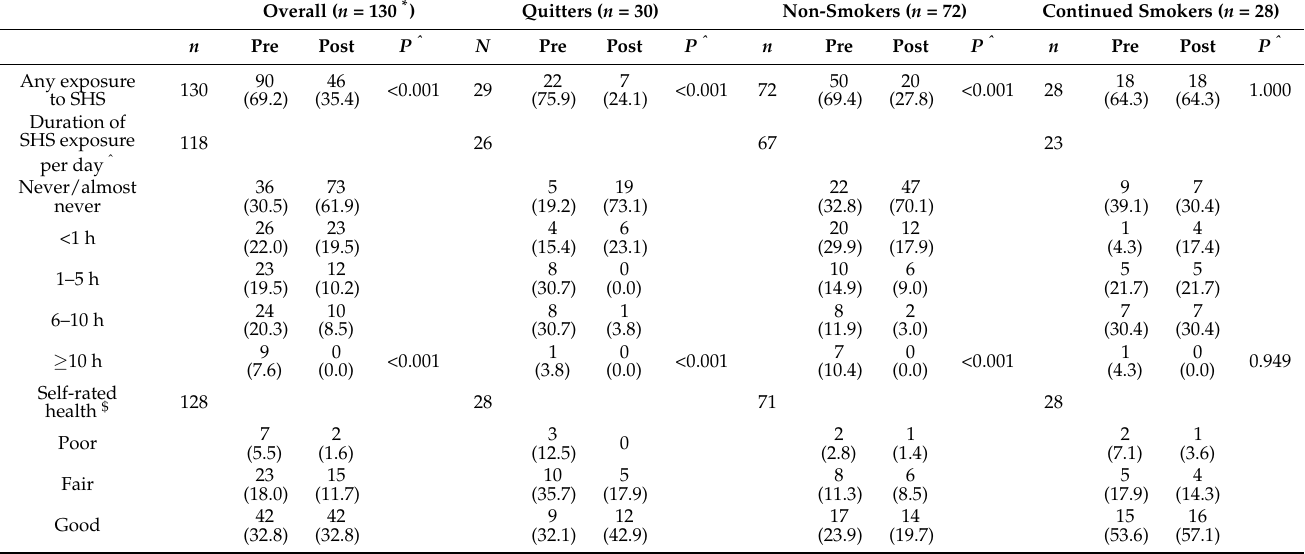
Table 3. Changes in Self-Reported Exposure to Second-hand Smoke and Self-Rated Health. Overall ( n = 130 * ) Quitters ( n =